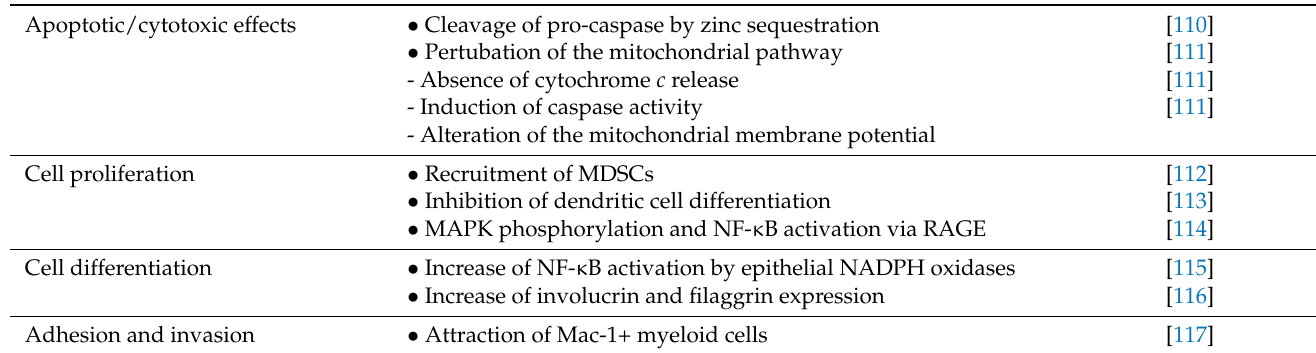
Table 2. Role of S100A8/S100A9 in the